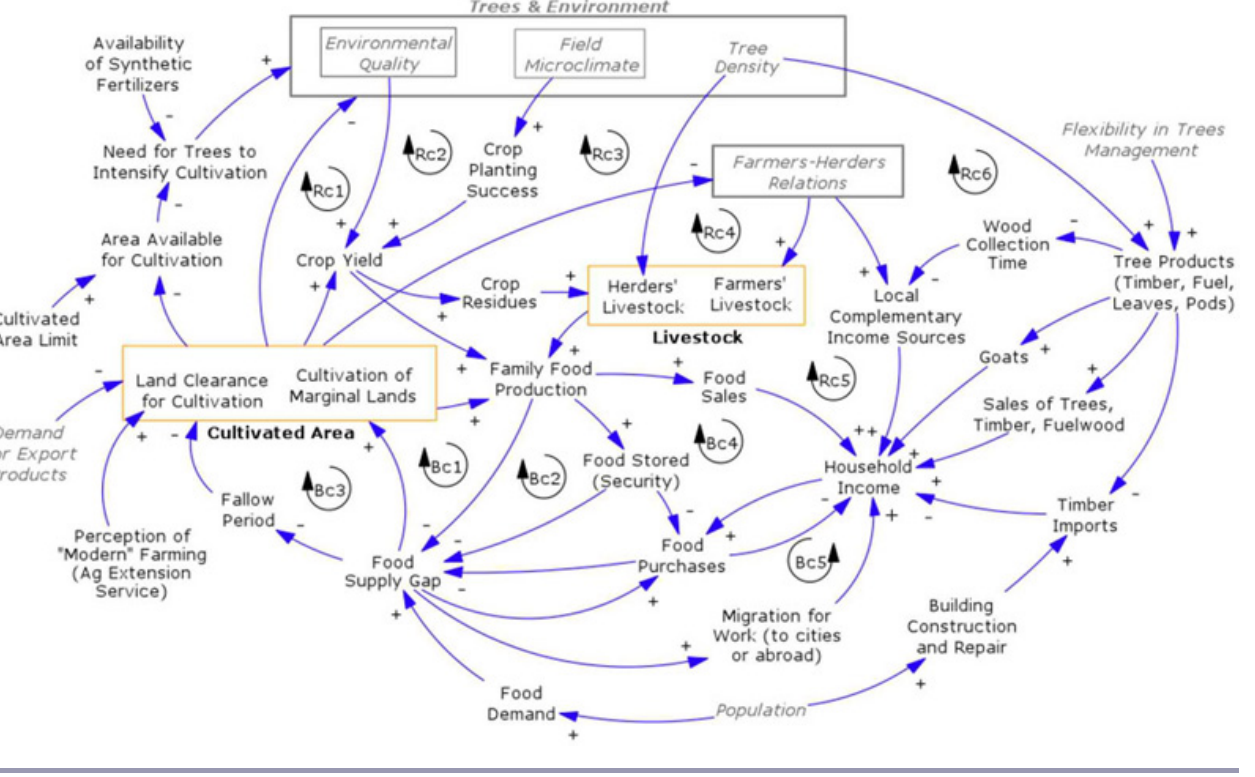
Fig. 6 . Household economy: relations between environmental, agricultural, and household economies, modeled at the field-to-commune